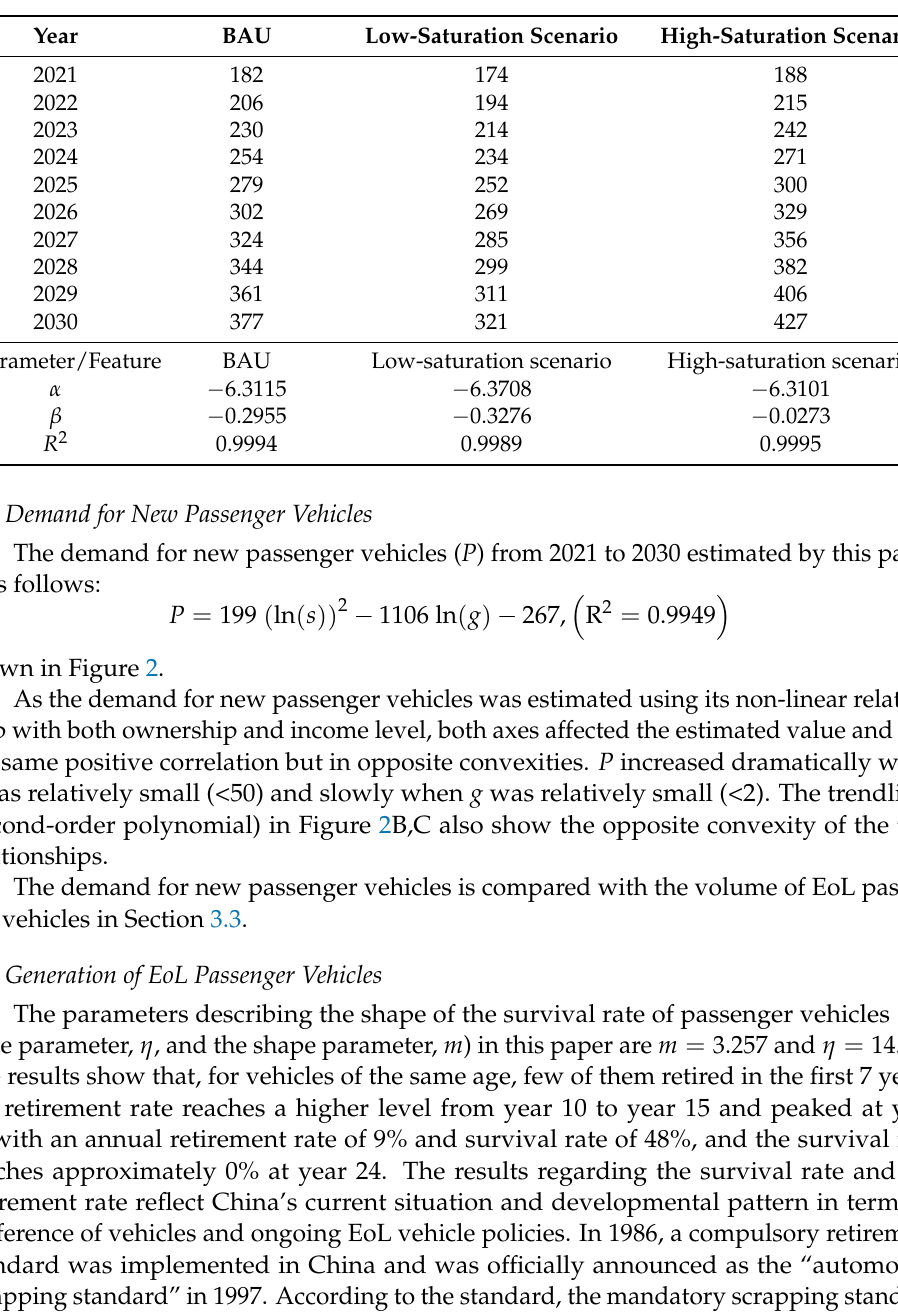
Table 1. Estimation of passenger vehicle ownership per 1000 people from 2021 to